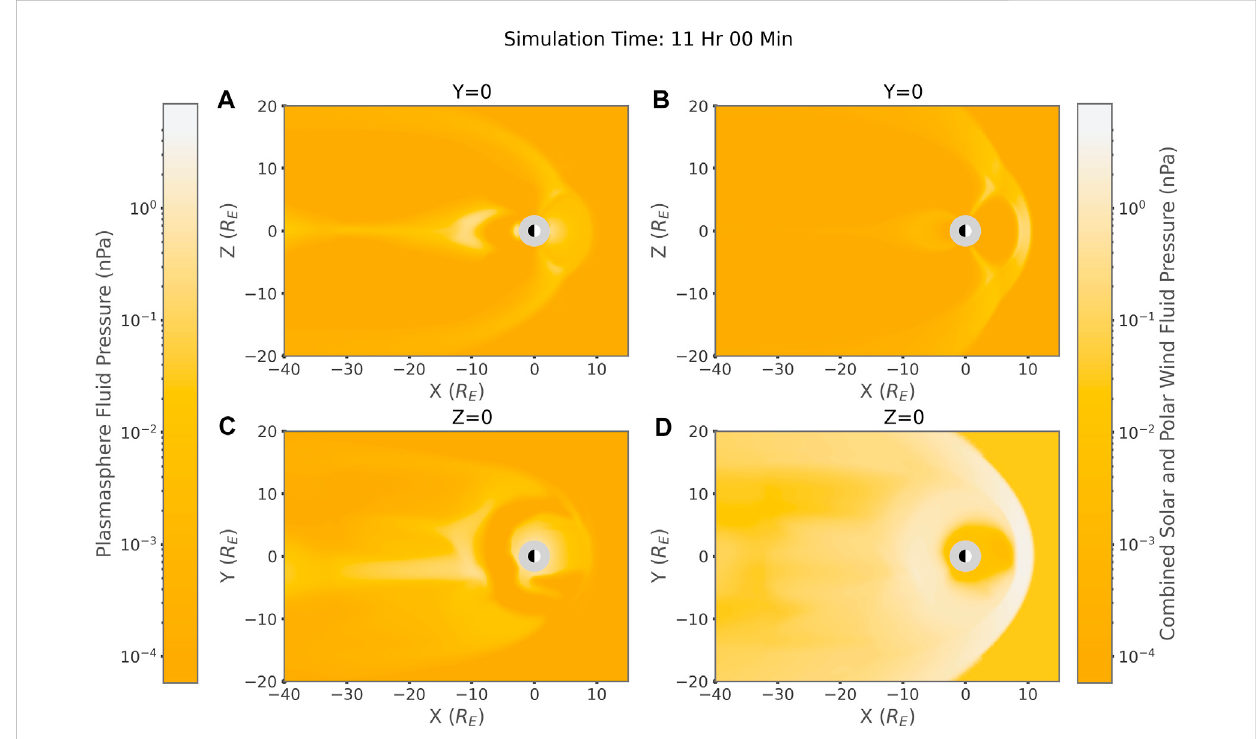
FIGURE 13 Taken from BATS-R-US at 11 h into the Idealized CIR simulation. (A, C) Y = 0 and Z = 0 slices pressure of plasmasphere fl uid respectively. (B, D) Y = 0 and Z = 0 slices pressure of combined solar and polar wind fl uid